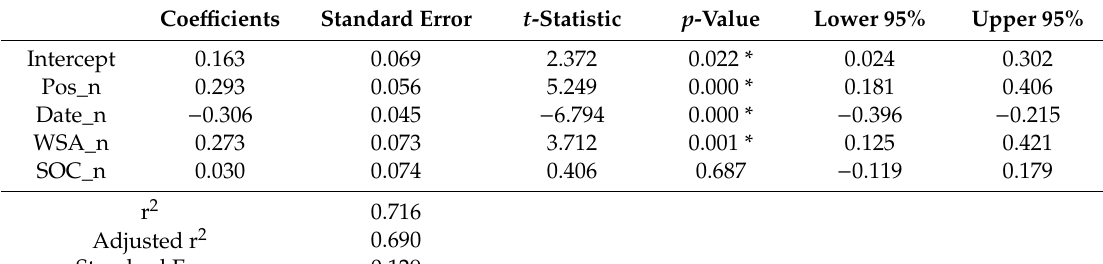
Table 6. Results of MLR analysis. The * indicates that the e ff ect is significant by the level of 5%. Coe ffi